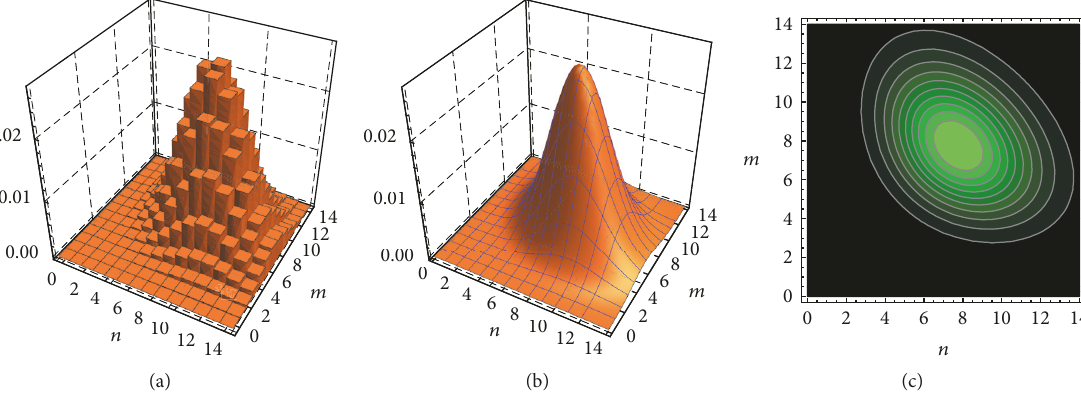
= 16 , the probability P (𝑛,𝑚, 16.7442) of 퐸 퐸 is defined in (35) as a function of |𝑧| . Compare with Figure 3. 퐸